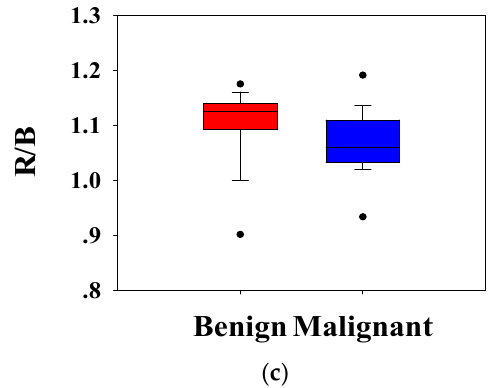
Figure 5. Box plots of R − B ( a ), ( R − B ) / G ( b ), and R / B ( c ) of H-scan ultrasound images for benign and malignant breast lesions. The p -values using the Mann–Whitney U test for ( a ) – ( c ) were smaller than 0.001, and the group value of benign and malignant breast tumors came from different distributions ( p -values < 0.01).